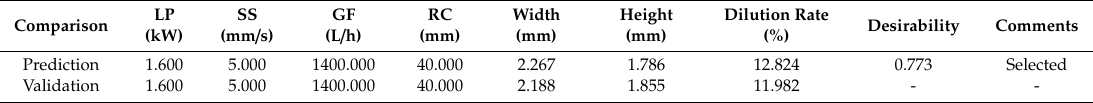
Table 8. Comparison between predicted optimization results and experimental